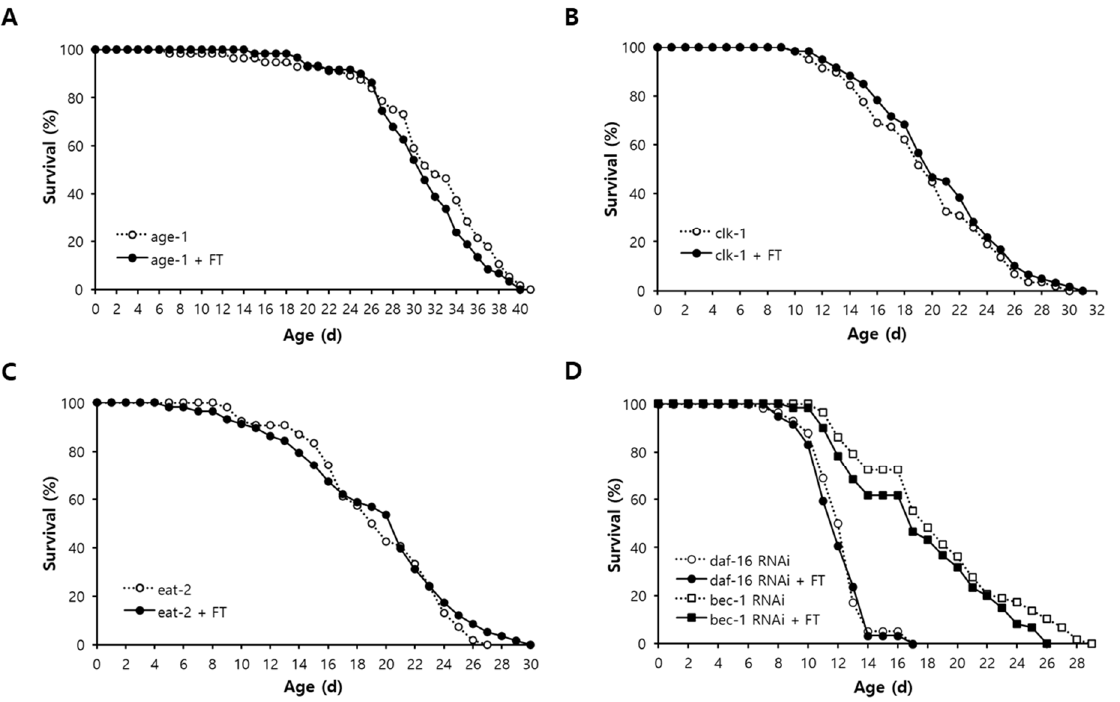
Figure 5. Effect of fisetin on lifespan of long-lived mutants. Effects of supplementation with fisetin on long lifespans of age-1 ( A ), clk-1 ( B ), and eat-2 ( C ) were examined with sixty age-synchronized worms. ( D ) Survival curves of worms with or without fisetin were compared when the expression of daf-16 or bec-1 was repressed. Genetic knockdown of daf-16 and bec-1 was performed using RNAi clones. The log-rank test was employed for statistical analysis of survival curves. FT, 0.1 g/L of fisetin; RNAi, RNA interference.